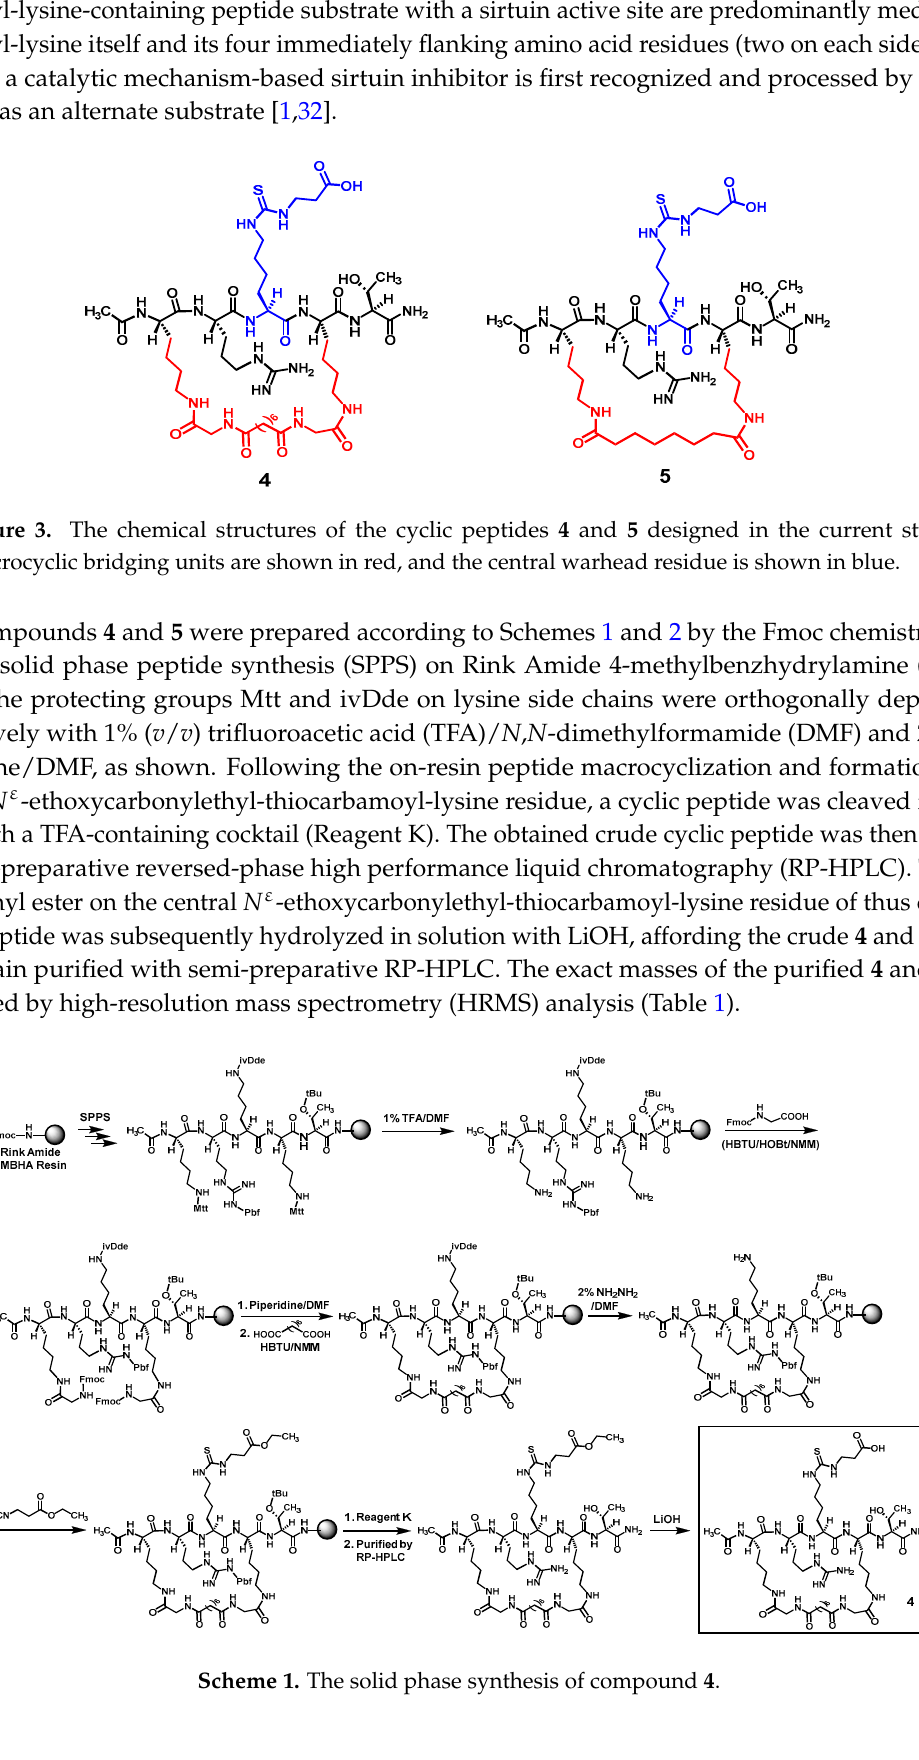
Scheme 1. The solid phase synthesis of compound 4 .